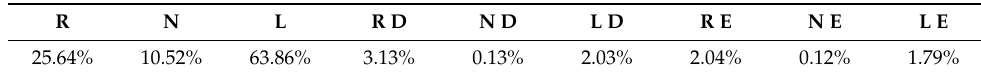
Table 3. Percentage of relevant Tweets that contain disinformation or extreme opinions, with different political affiliations; R stands for rightist, N for neutral, L for leftist, D for disinformation, and E for extreme opinion.